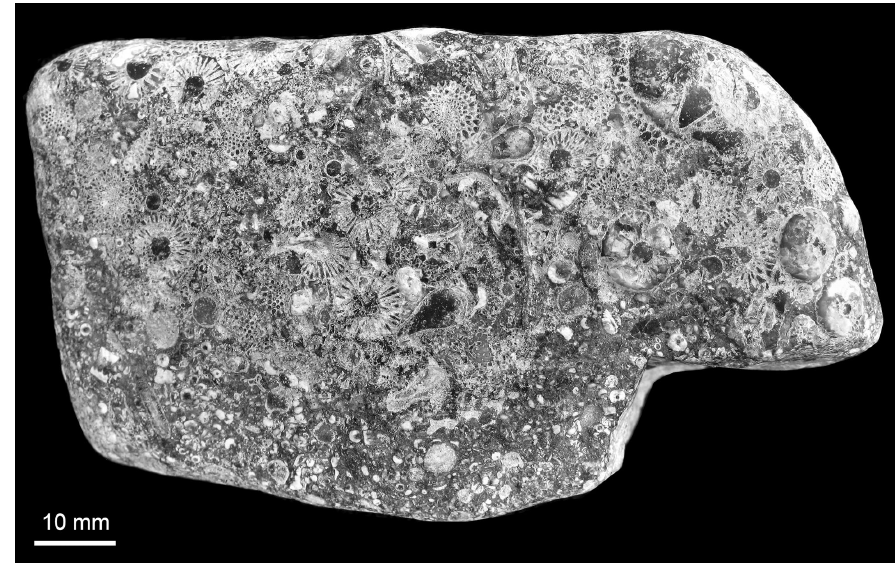
Fig. 16. Boulder of silicified limestone showing transverse sections of Coelosphaeridium sphaericum , Apidium sp. and Mastopora concava . PMU 31615, Tofta (beach),